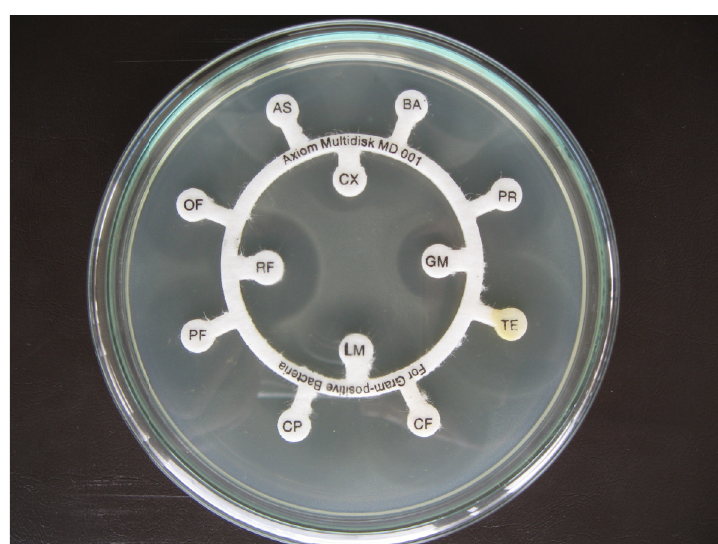
Fig. 2. Inhibition zones produced by standard